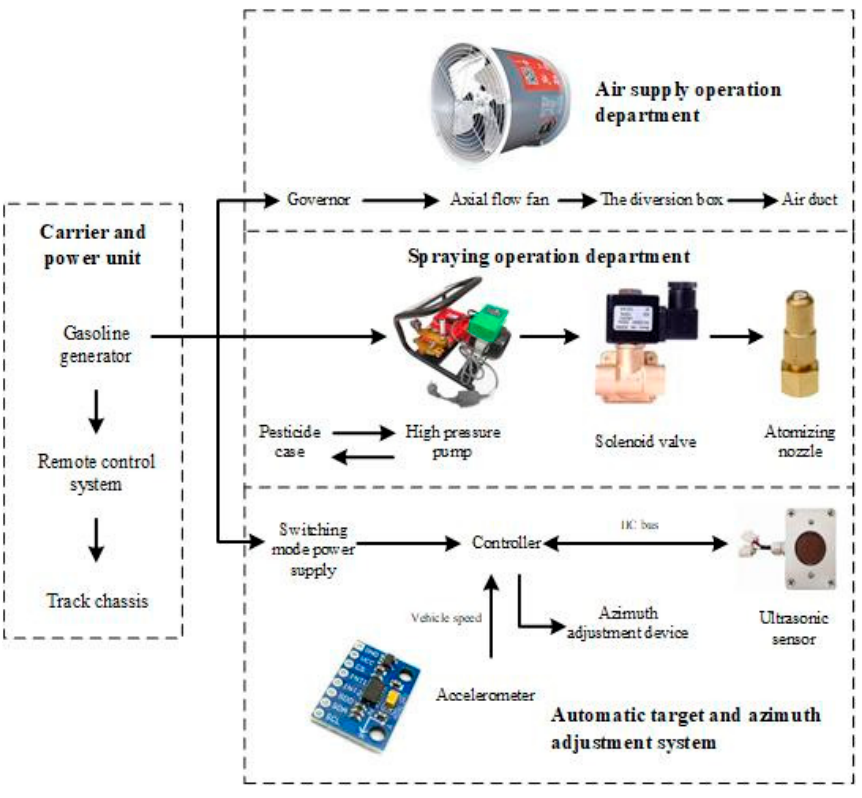
Figure 2. Working principle.